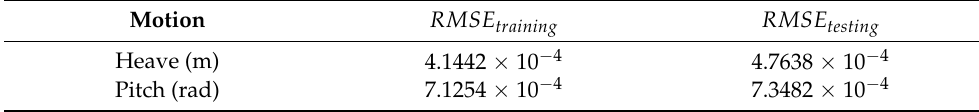
Figure 5. The one-step-ahead prediction of pitch motion in irregular waves for the R-Class Icebreaker model. Table 5. The RMSE of the identified wavelet model.